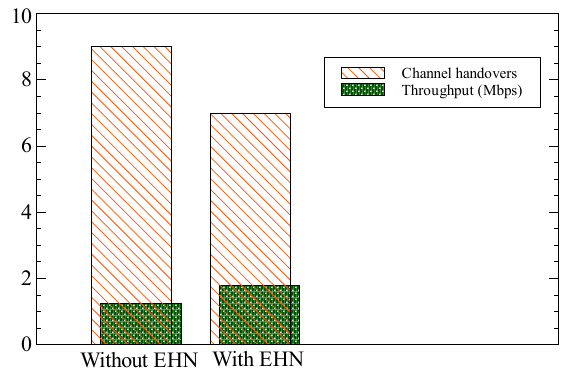
With EHNWithout EHN Figure 7. Achieved throughput and performed